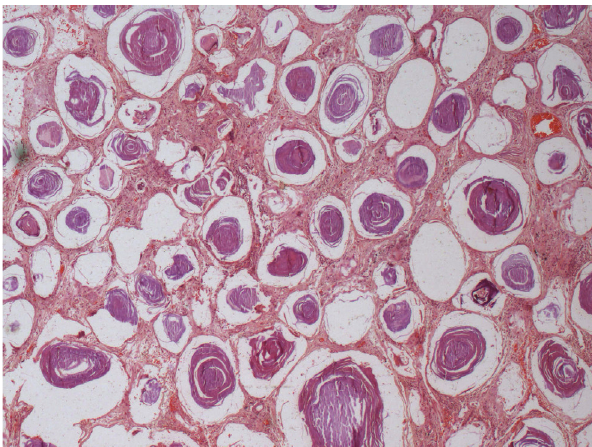
Figure 3 - Hystologic specimen from the explanted lung demonstrat- ing the pulmonary histological structure diffusely altered due to alveoli filled by multiples microliths. The interstitial septa is enlarged by fibrosis (hematoxylin-eosin